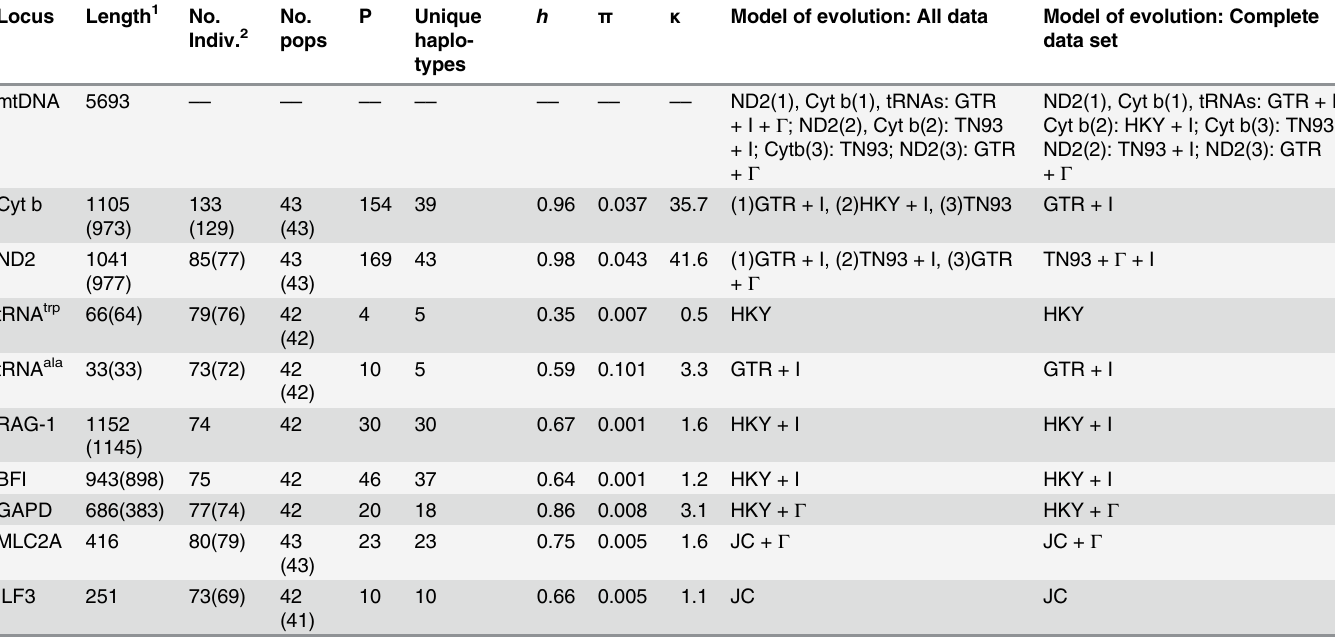
Diversity indices: P, the number of polymorphic sites; Unique haplotypes: the number of unique haplotypes in the sample; haplotype diversity, h , the probability that two randomly selected haplotypes are different from each other; nucleotide diversity, π , the average number of nucleotide differences per site between two sequences; sequence diversity, κ , the average number of nucleotide differences between paired sequences [78]. 1. Sequence length. Numbers in parentheses are the length of the sequence used to calculate diversity indices after omitted all sites with missing data. 2. Number of individuals. Numbers in parentheses are after excluding short sequences, which were not used to calculate diversity indices because they exclude sites with missing